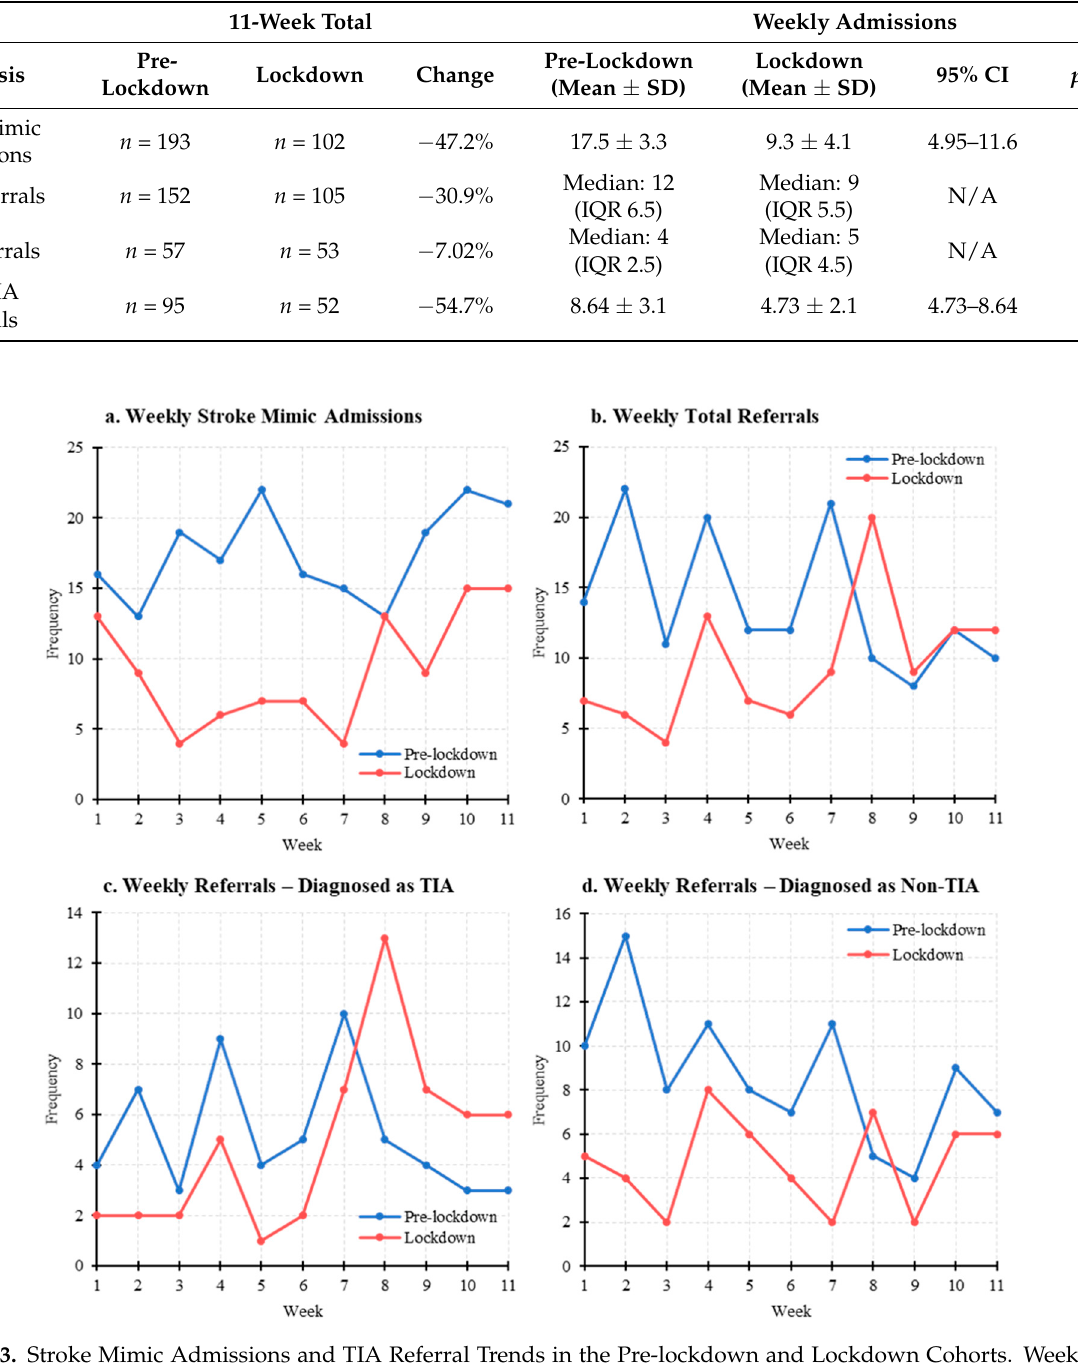
Figure 3. Stroke Mimic Admissions and TIA Referral Trends in the Pre-lockdown and Lockdown Cohorts. Weekly ( a ) stroke-mimic/non-stroke admissions, ( b ) total referrals made to the Royal Victoria Infirmary Hyperacute Stroke Unit, ( c ) referrals diagnosed as TIA, ( d ) referrals diagnosed as non-TIA data in the pre-lockdown (blue) and lockdown (red) cohorts. TIA: transient ischaemic attack.